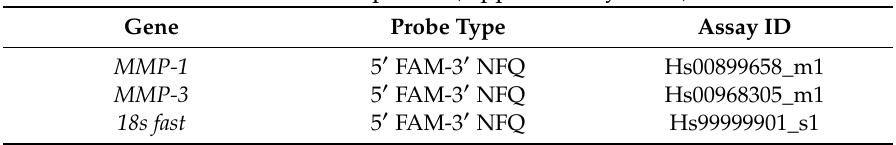
Table 4. Oligonucleotide primers and probes ( human ) used for Real-Time PCR. a. Primers and probes (Applied